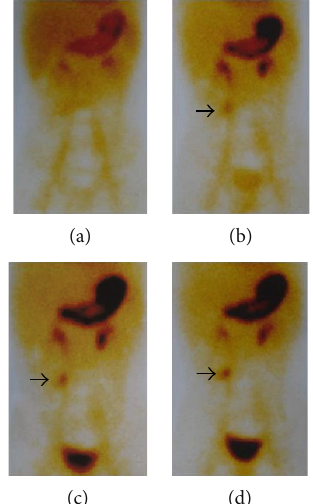
Figure 1: A 12-year-old boy with massive lower gastrointestinal bleeding; 99m Tc-pertechnetate scan was positive. The arrows show the existence of ectopic gastric mucosa.